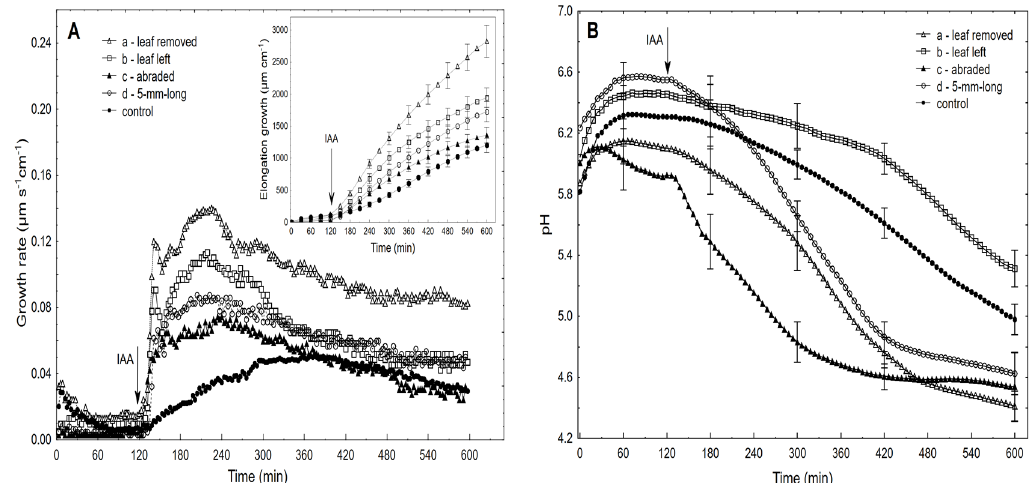
Figure 1. Effect of the IAA (10 − 4 M) on the growth rate (µm s − 1 cm − 1 ) and medium pH of the maize coleoptile segments. The IAA-induced growth ( A ) and medium pH ( B ) of the coleoptile segments: with (a) or without (b) the first leaf removed, with a partially abraded cuticle (c) and segments cut to half of their length (5-mm-long segments) (d). The control represents the growth rate of the coleoptile segments in the auxin-free medium (endogenous growth). The coleoptile segments were first preincubated (over 2 h) in an auxin-free medium to which the IAA at a final concentration of 10 − 4 M was added (arrow). The inset shows the total IAA-induced elongation growth, which was calculated as the sum of the extension from 3 min interval measurements over 10 h. All of the curves are the means of at least eight independent experiments. Bars indicate ± SE.